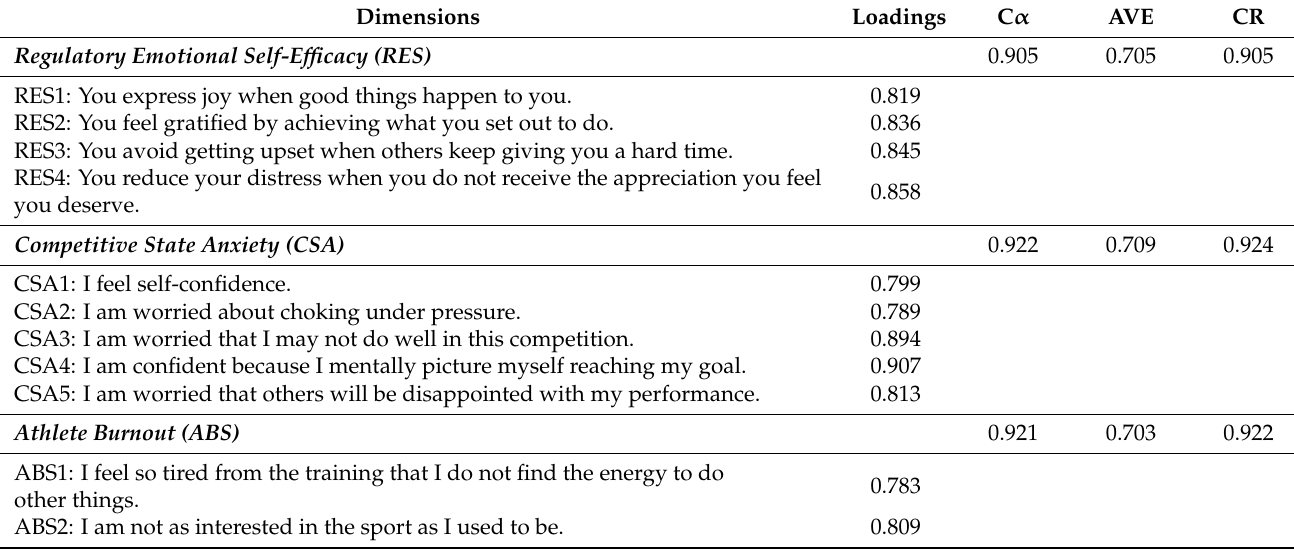
Table 2. Reliability and validity